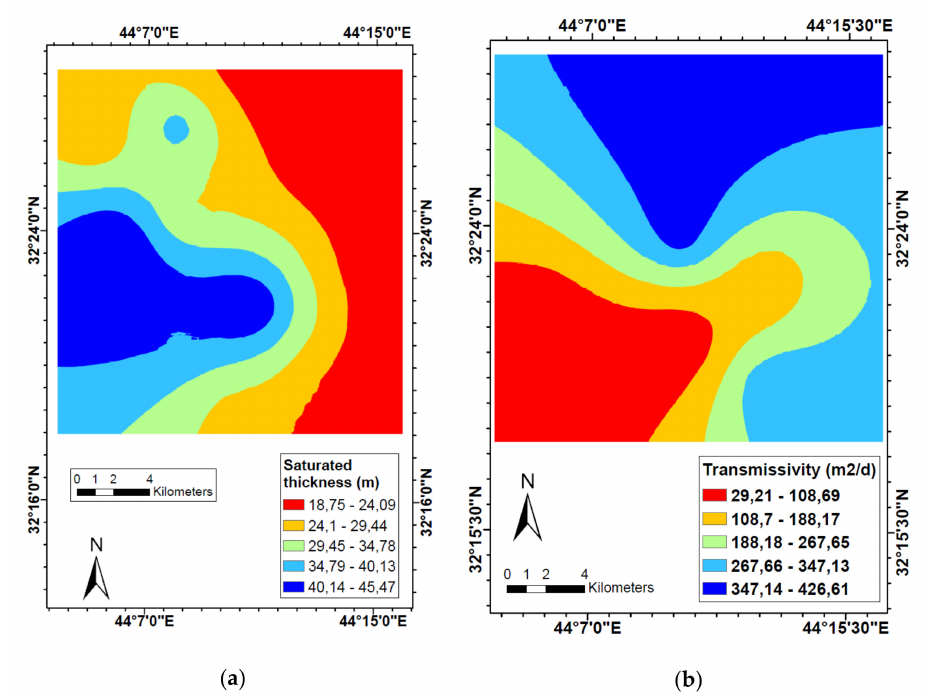
Figure 16. Maps of Babylon aquifer: ( a ) saturated thickness; ( b ) transmissivity of Babylon aquifer. Both maps are modified after